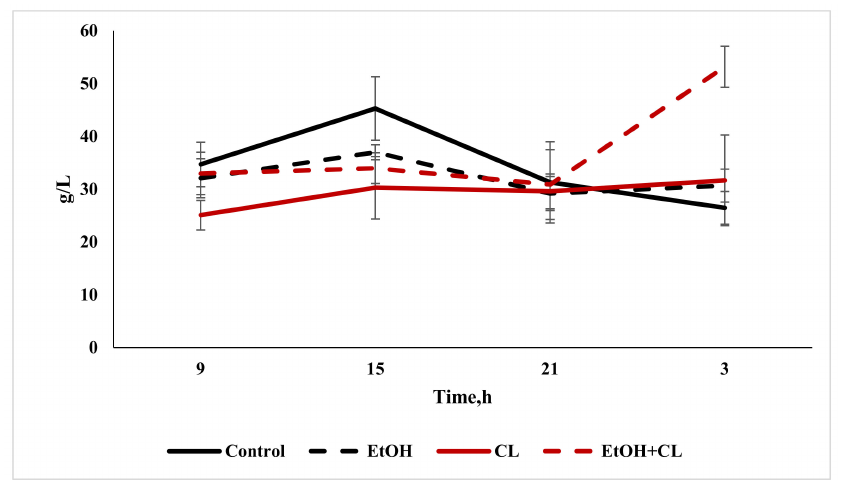
Figure 14. Daily fluctuations in albumin levels in the blood plasma of rats.